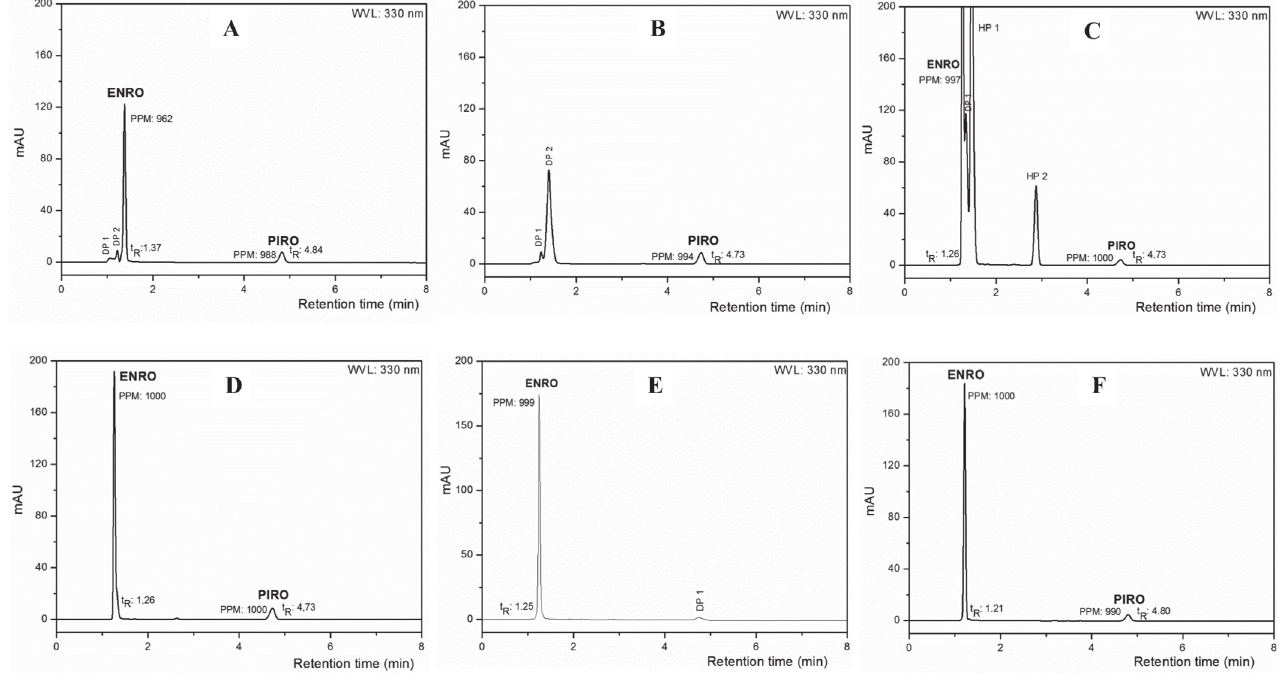
FIGURE 3 - Chromatogram of enrofloxacin and piroxicam under acidic hydrolysis (A), alkaline hydrolysis (B), oxidation (C), high temperature (D), 8 hours of sunlight (E) and 92 hours of fluorescent light exposure (F). DP, degradation product; PPM, peak purity match factor; t , retention time. Conditions : mobile phase composed of acetonitrile:water (48:52, v/v); pH 3.0; column Vertisep R C18; flow rate 1.0 mL min –1 ; injection volume 20